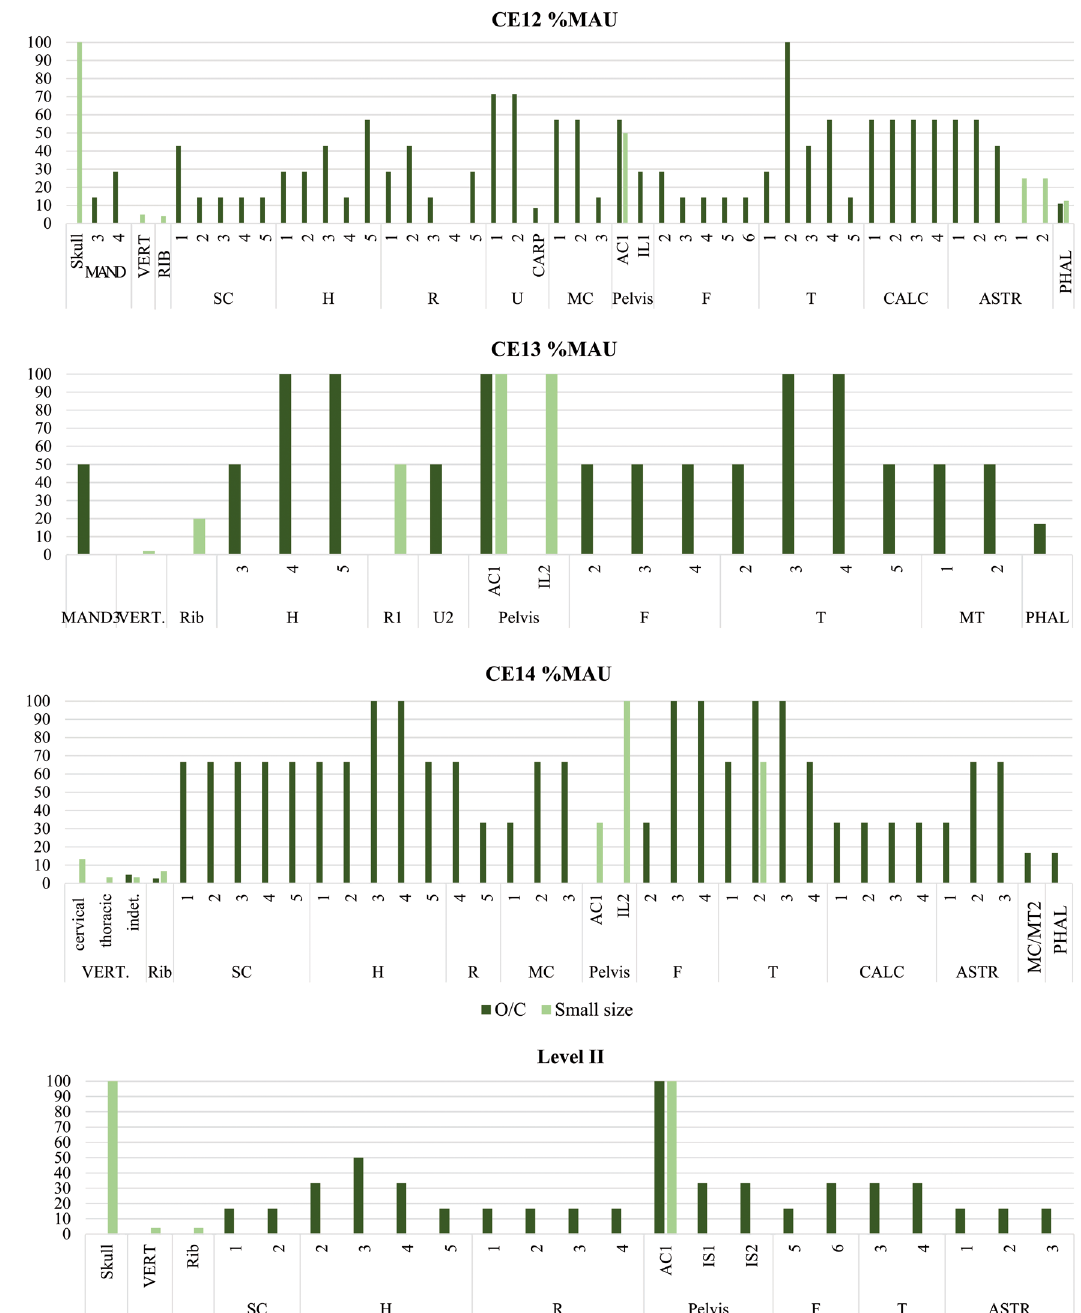
Figure 4: Graphic representation of the %MAU of sheep and goats of all levels with more than 10